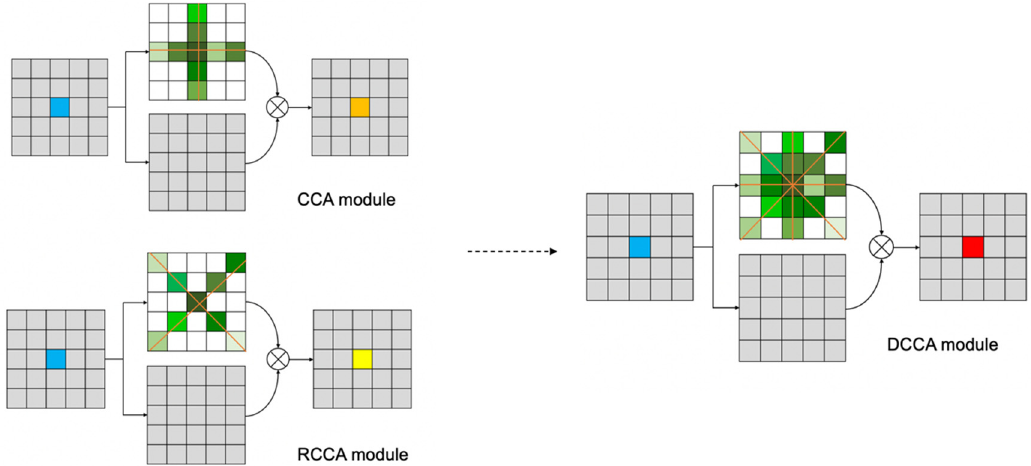
Figure 9 . The relation information transference in RCCA . Figure 9. The relation information transference in RCCA.